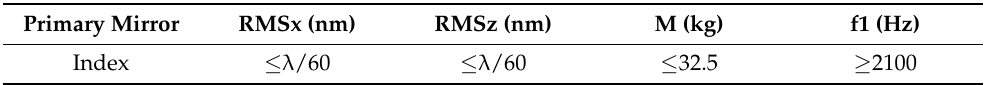
Table 2. Design requirements of primary mirror.